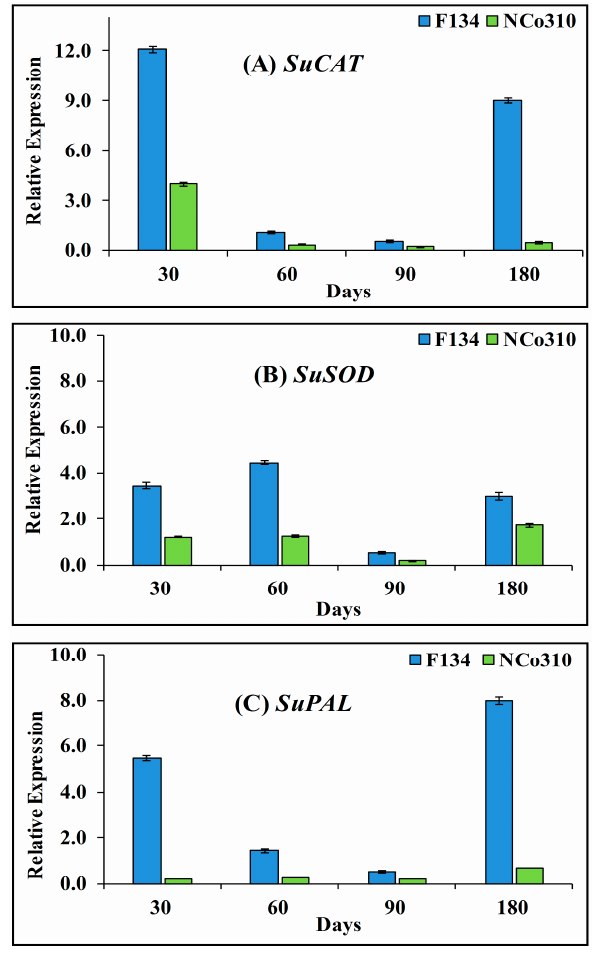
Figure 3. qRT-PCR analysis of differentially expressed genes in leaf tissue of sugarcane varieties F134 and NCo310 during sugarcane– S. scitamineum interaction. ( A ) Catalase ( SuCAT ), ( B ) superoxide dismutase ( SuSOD ), and ( C ) phenylalanine ammonia lyase ( SuPAL ). Data were normalized to the GAPDH expression level. All data points are the mean ± SE ( n = 3).